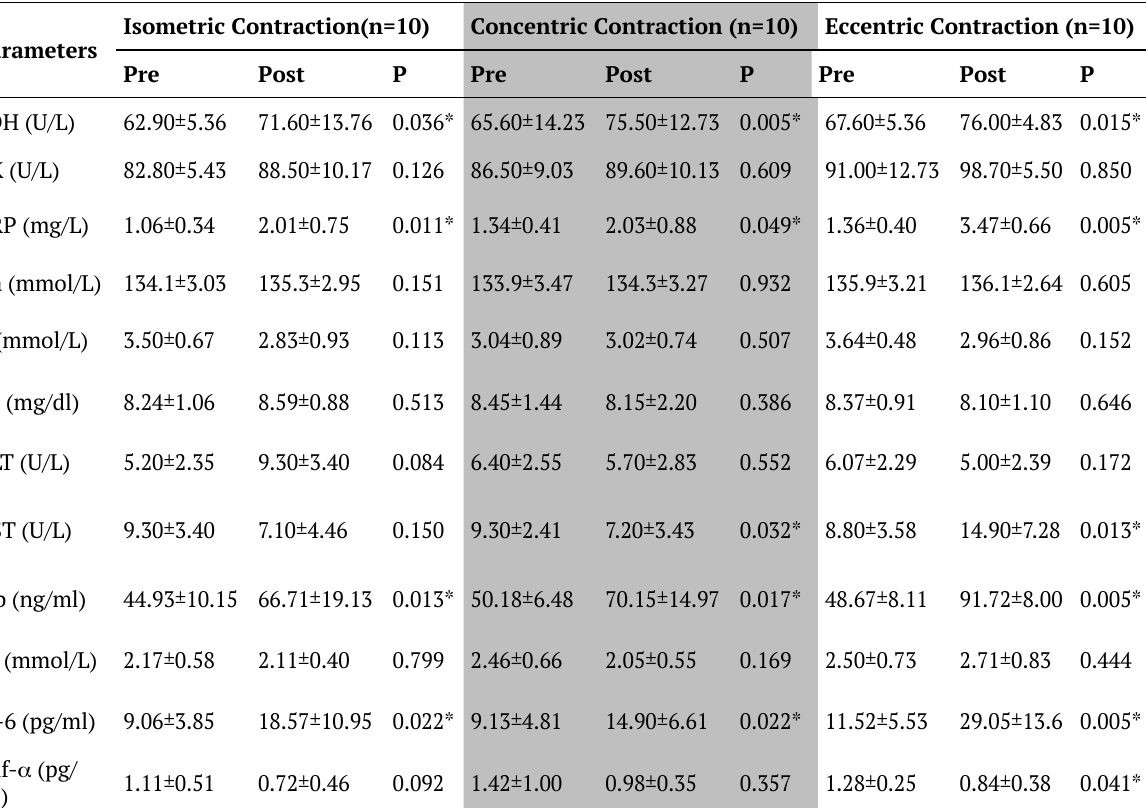
Table 2. Comparison of pre-study and post-study biochemical parameters of groups